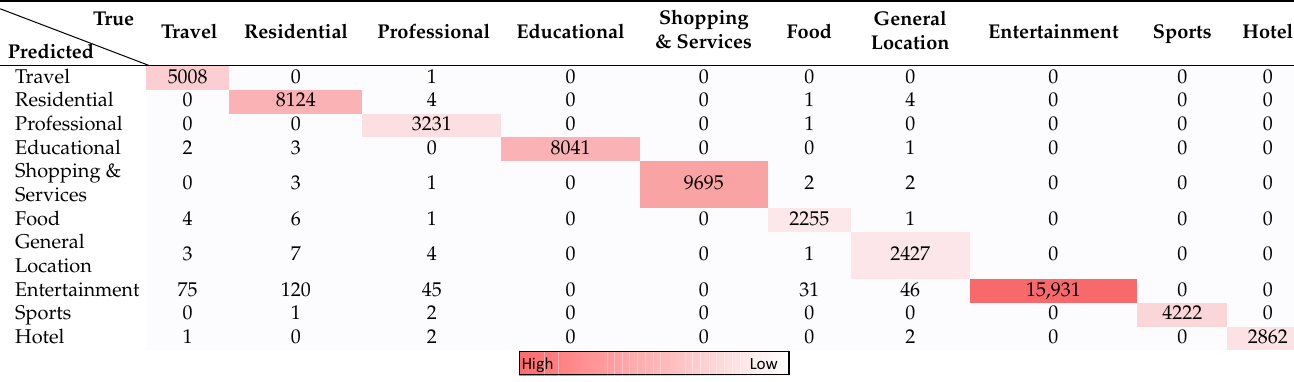
Table 4. Confusion Matrix for Deep-Learning Model.